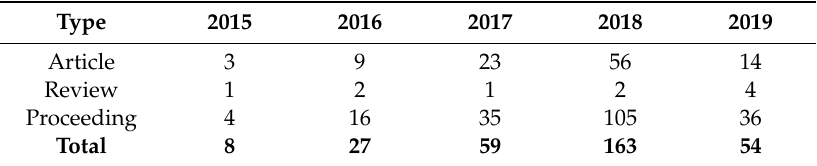
Table 2. Numbers of papers in Scopus database based on the query “Industry 4.0” OR “Industrial revolution 4.0” AND TOPIC “construction” OR